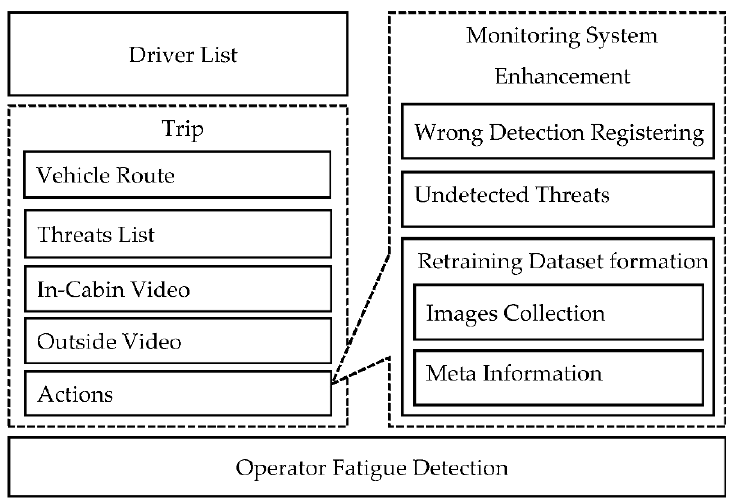
Figure 3. Reference model of operator–computer interaction interface.